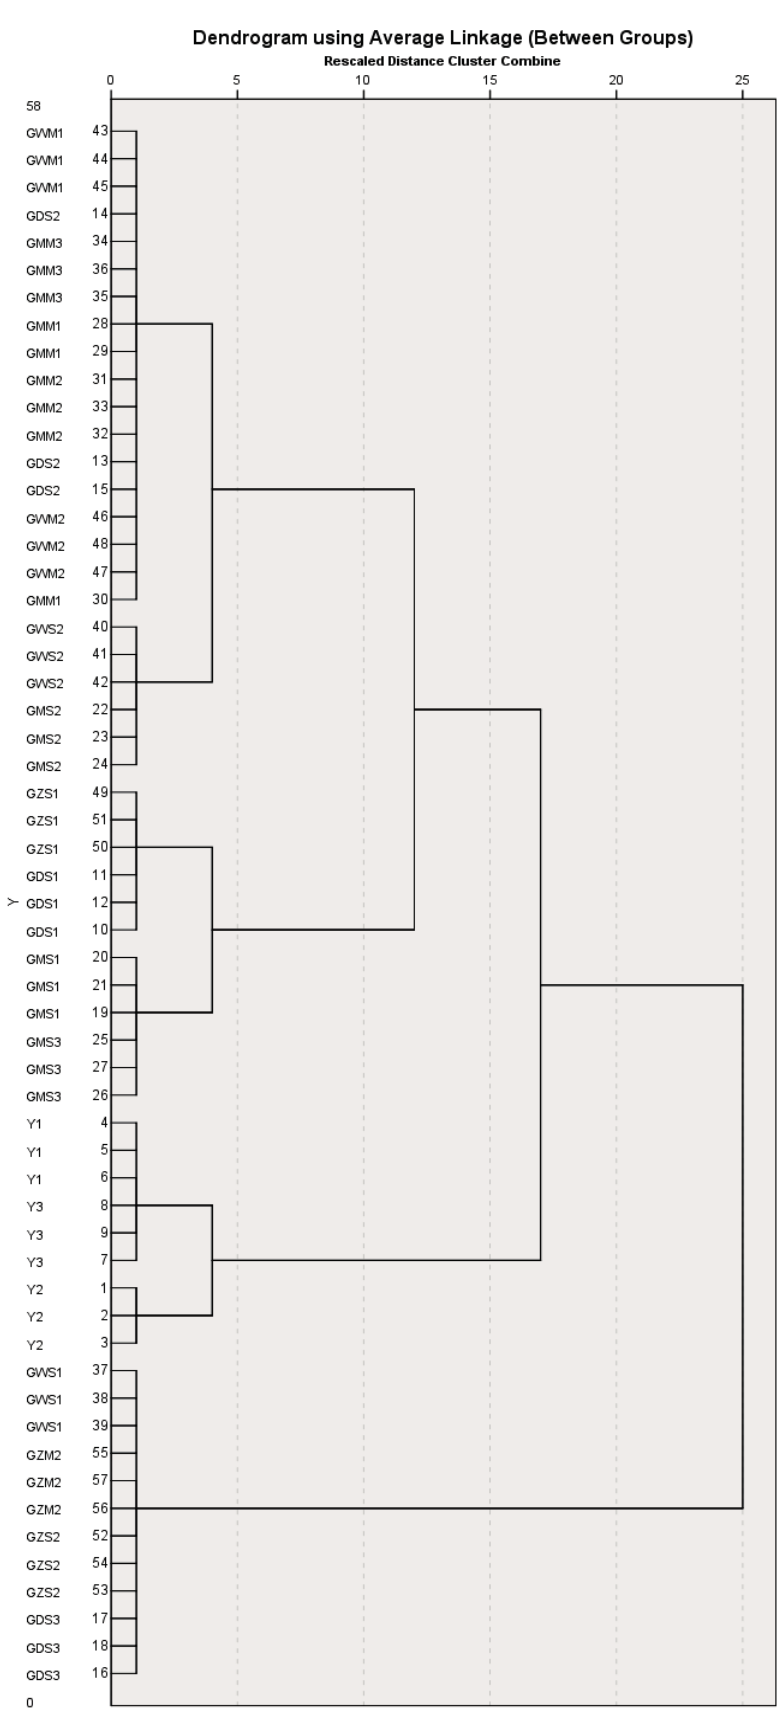
Figure 4. Hierarchical clustering analysis (HCA) dendrogram for samples